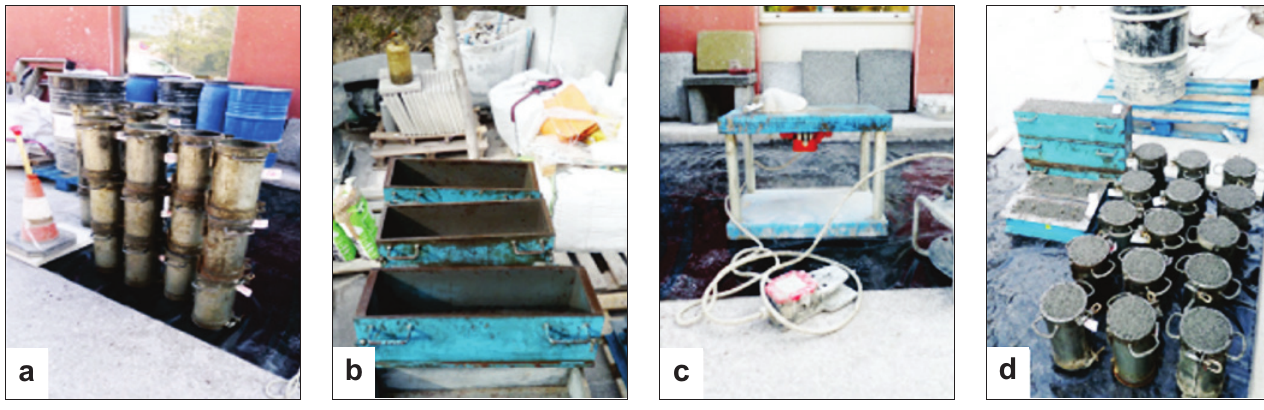
Moldagem e compactação corpos de